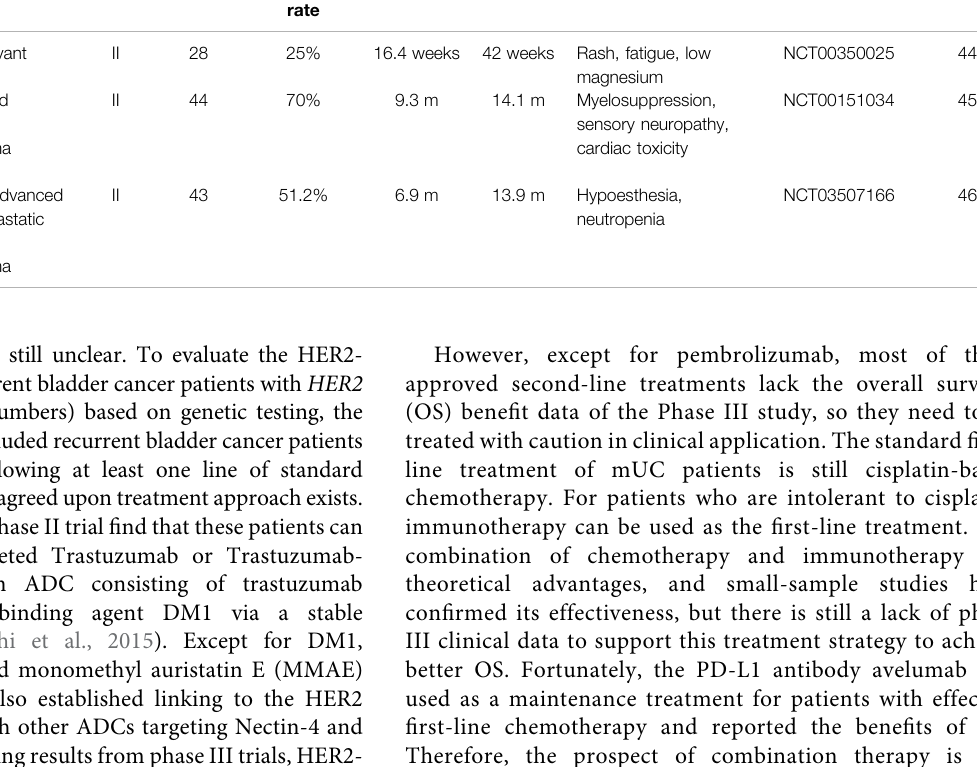
TABLE 1 | Results from clinical trials of HER2-targeted antibodies or ADC drugs.